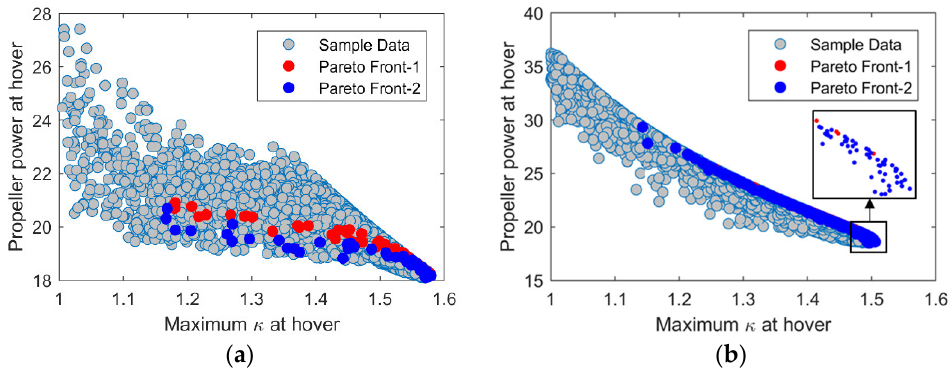
Figure 25. Relationship between hover power and maximum thrust-to-weight ratio at hover. ( a ) VPP; ( b ) FPP.